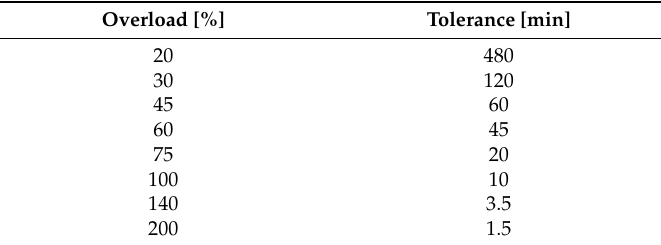
Table 1. Overload-tolerance relation of 220-kV mineral-oil-immersed transformers.